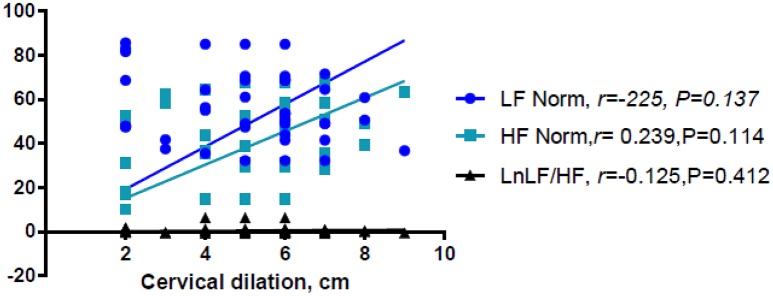
Correlations between cervical dilation and LF Norm, HF Norm, and LnLF/HF.